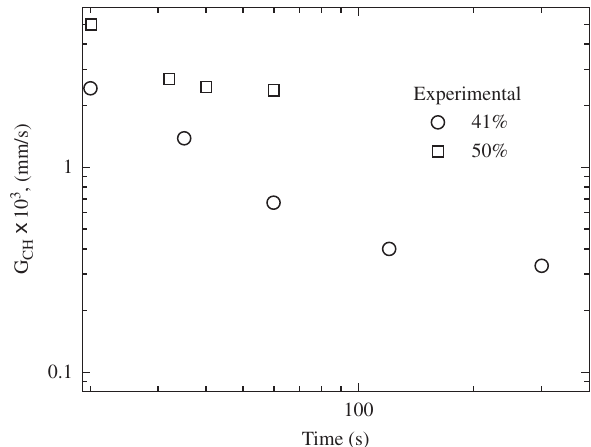
Figure 13. Variation of the average migration rate (V time at 400 °C for two levels of cold working (41 and 50%) in the AA3003 aluminum alloy 113,114